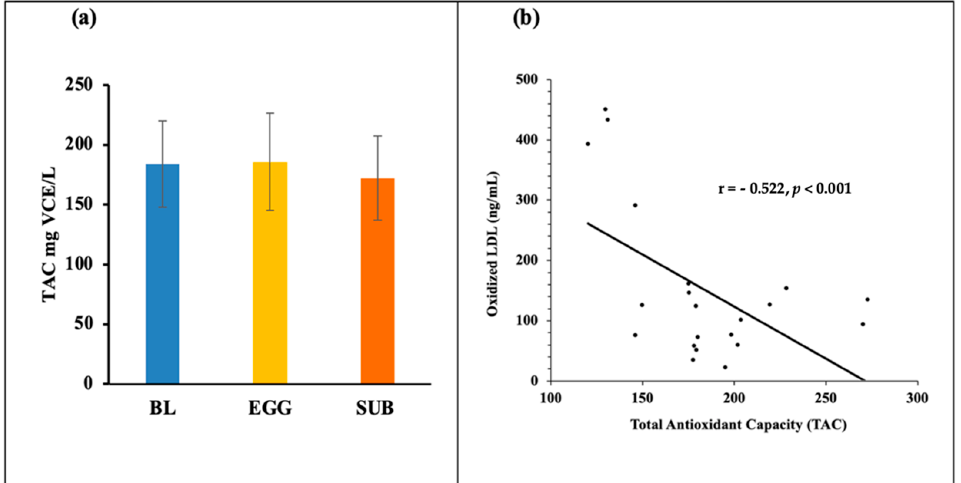
Figure 3. The concentratio of lipid peroxidation product, MDA negatively correlated with the con- centration of plasma zeaxanthin after EGG intervention for n = 24